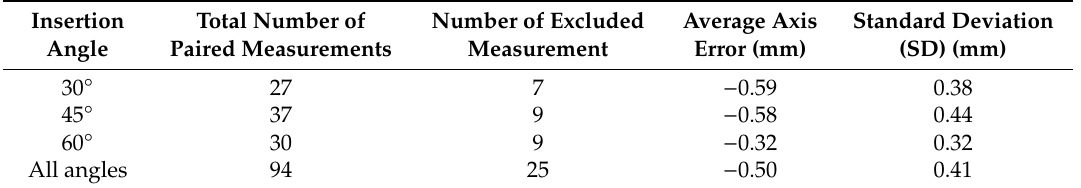
Table 2. Needle tip localization error determined by the axial distance comparison between Doppler and photographic measurements.